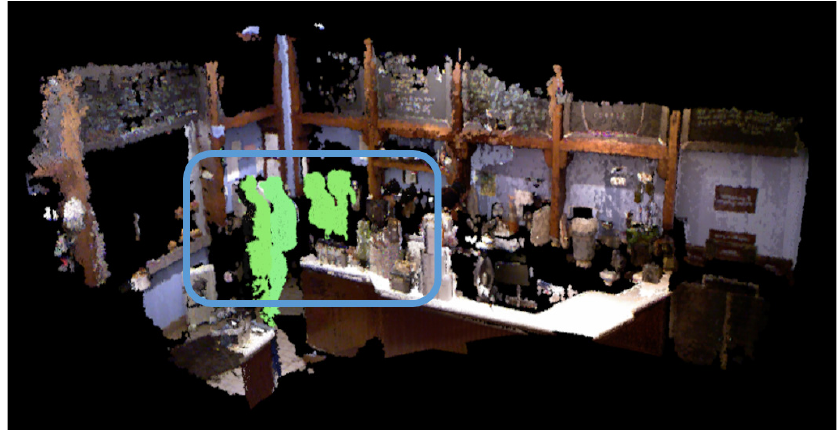
Figure 15. Pedestrian trajectory in static maps. The green pedestrian labels from right to left in the figure are the positions of pedestrians at times 1–4.